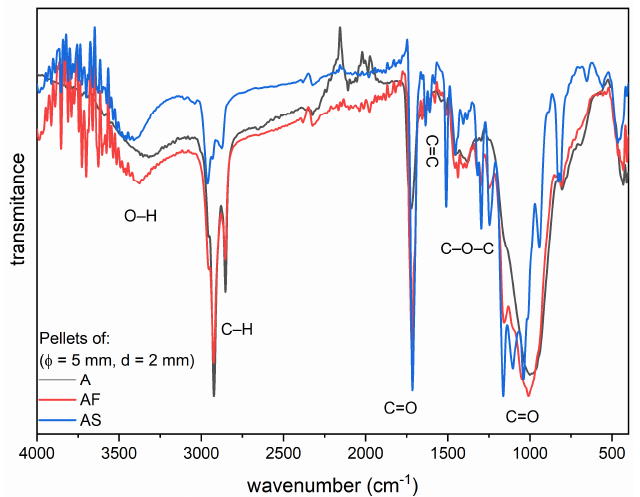
Figure 3. FTIR spectra of ormocer materials light-cured for 40 s. The study was performed for one randomly selected sample of each material: A—Admira; AF—Admira Flow; AS—Admira Seal. Release of fluoride ionsfrom A, AF and AS materials into the saline solution was showed in Table 2. Table 2. Release of fluoride ions ( μ g/mm 2 ) from ormocer materials (A—Admira; AF—Admira Flow; AS—Admira Seal) into a saline solution (0.9% NaCl) in a period of 2352 h. Five samples were prepared for each material. Time (Hours)